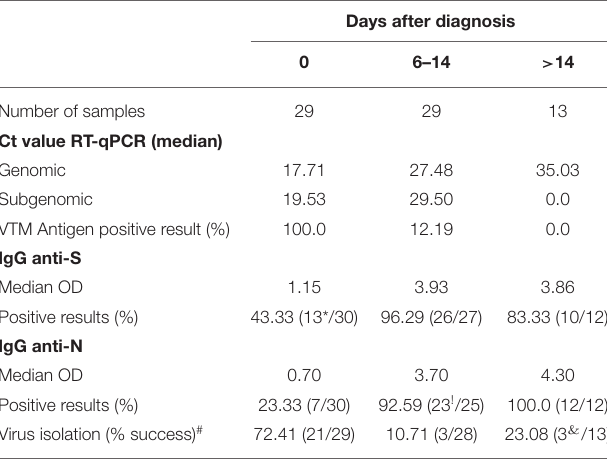
TABLE 1 | Summarized data from follow-up samples.